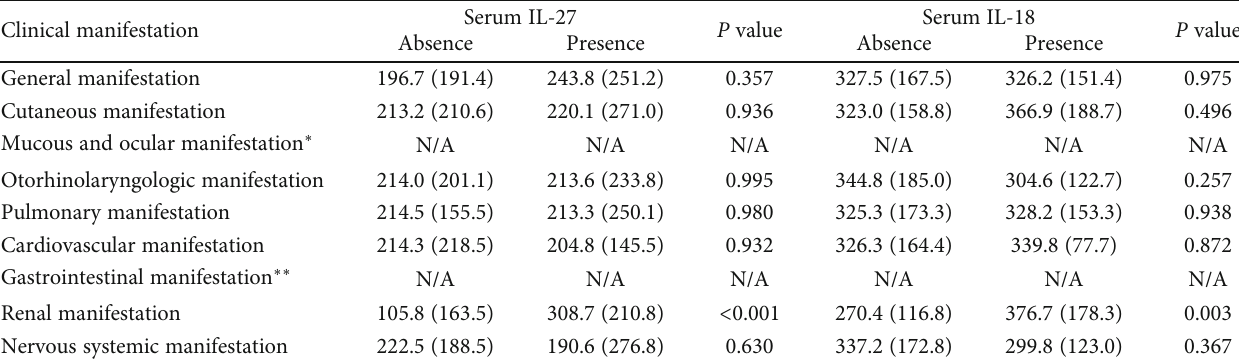
Table 4: Comparison of serum IL-27 and IL-18 levels according to the presence and absence of clinical manifestations.